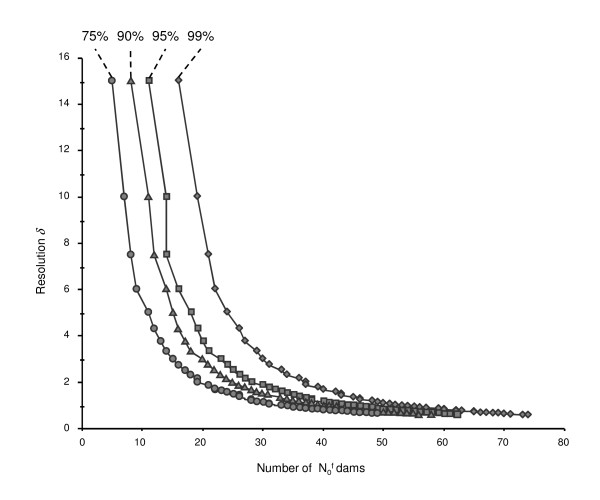
Distribution of the mapping resolution (δ) depending on the number of LW dams N0f in the case of an initial QTL interval of 30 cM, for overall probability of success of around 99%, 95%, 90% and 75%.